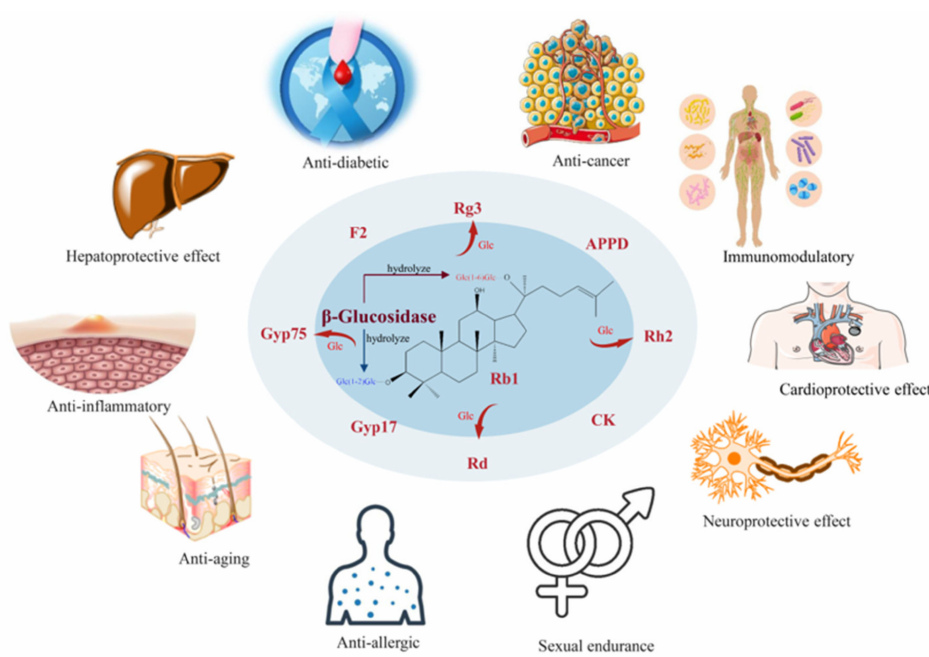
Figure 1. The biological activities of deglycosylated ginsenosides. The picture materials were downloaded from Vecteezy (https://www.vecteezy.com, accessed on 11 November 2022) and Smart (https://smart.servier.com, accessed on 11 November 2022), which provide free